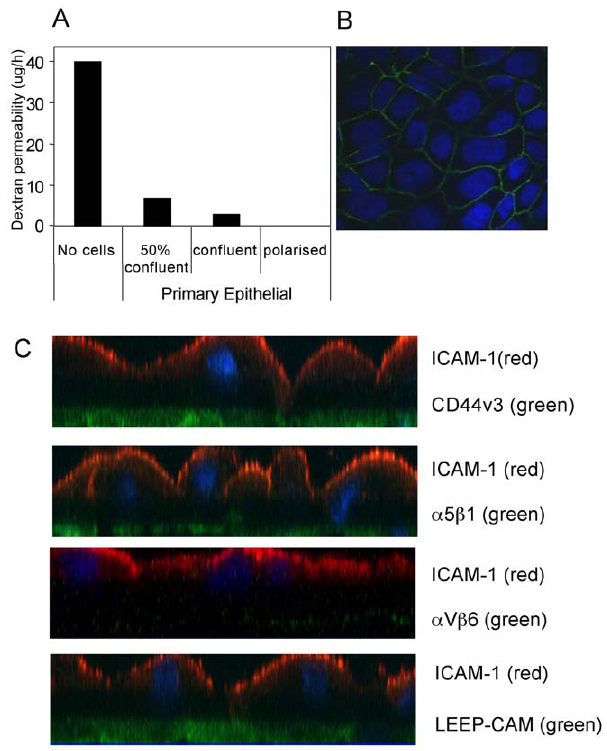
Figure 4. Polarization of primary tonsillar epithelial cells. (A) Primary tonsillar epithelial cells were seeded in triplicate onto 8.0 m M pore-size Transwells. FITC-dextran was added to the medium in the upper reservoir at 50% confluence, fully confluent and 6 days post confluence (polarized). After 3 hours, aliquots of the medium from the lower (basolateral) chamber was analysed for the concentration of FITC- Dextran. The results are plotted as the mean of triplicate samples for each condition. (B) Polarized primary tonsillar epithelial cells were fixed in ice-cold methanol and stained with anti-E-cadherin antibody and visualised with anti-mouse AlexaFluor 488 secondary antibody. Confocal analysis through 1 m m X-Y sections show the staining is localised to the upper lateral membrane. (C) Polarized primary tonsillar epithelial cells were fixed in ice-cold methanol and stained with mAbs to ICAM-1, CD44v3, a 5 b 1 and a V b 6 and LEEP-CAM at both surfaces to determine which epithelial surface these molecules are expressed upon. The cells were examined by confocal microscopy and are represented as X-Z sections.